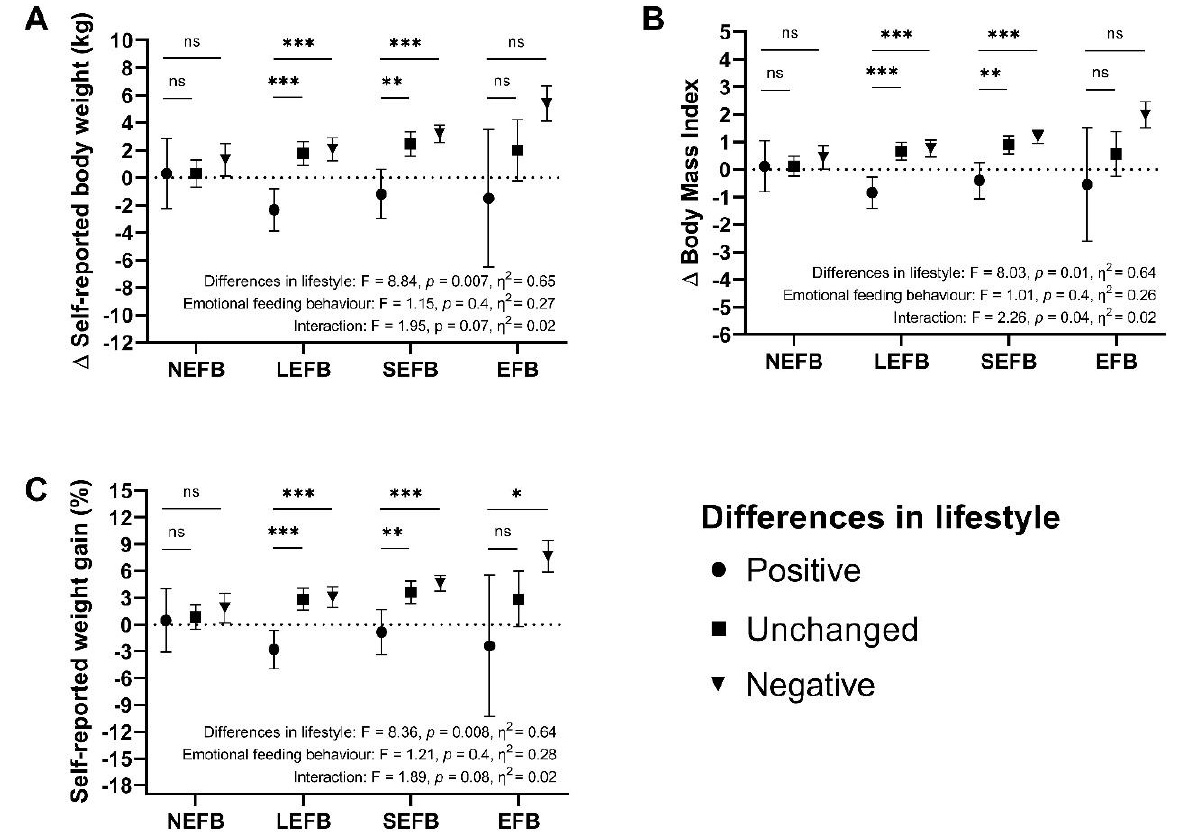
Figure 1. Results of the random effects models for the differences in self-reported ( A ). body weight, ( B ). BMI, and ( C ). percentage weight gain for differences in lifestyle adjusted for emotional feeding behaviour. Mean and 95%CI are shown. NEFB: No emotional eating behaviour, LEFB: Little emotional eating behaviour, SEFB: Some emotional eating behaviour, EFB: Emotional eating behaviour, ∆ : Difference, BMI: Body Mass Index, ns: No significance. *: p < 0.05, ** p < 0.01, *** p < 0.001.